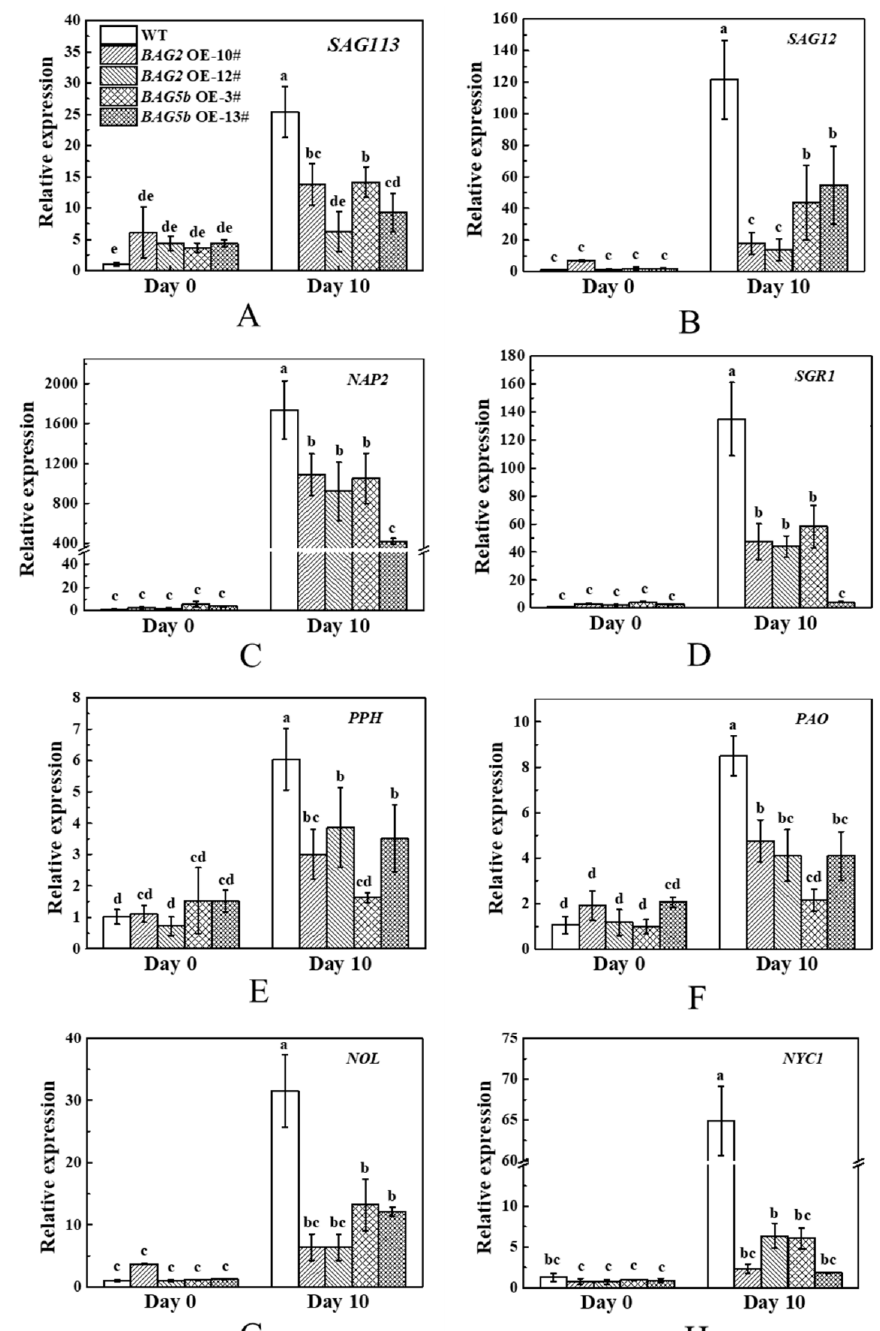
Figure 12. Expression of senescence related genes (( A ): SAG113 , ( B ): SAG12 , ( C ): NAP2 , and ( D ): SGR1 ) and chlorophyll degradation genes (( E ): PPH , ( F ): PAO , ( G ): NOL, and ( H ): NYC1 ) in WT, BAG2 OE, and BAG5b OE transgenic lines under dark stress. The young leaf samples were collected at the indicated time points and analyzed by qPCR. For each gene, the expression level of WT plants at 0 d was set as 1.0. Different letters indicate that the expression levels were significantly different at P < 0.05. 10# and 12# represent 2 lines of BAG2 OE plants; 3# and 13# represent 2 lines of BAG5b OE plants; OE, overexpression; WT, wild